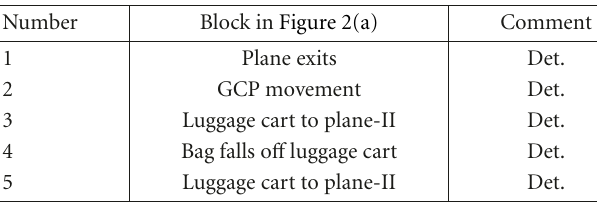
Table 1: TSA dataset: temporal segmentation of two blocks using the online BMS model. GCP = ground crew personnel, PAX = pas- sengers, Det. = segment detected, TF = tracking failed.